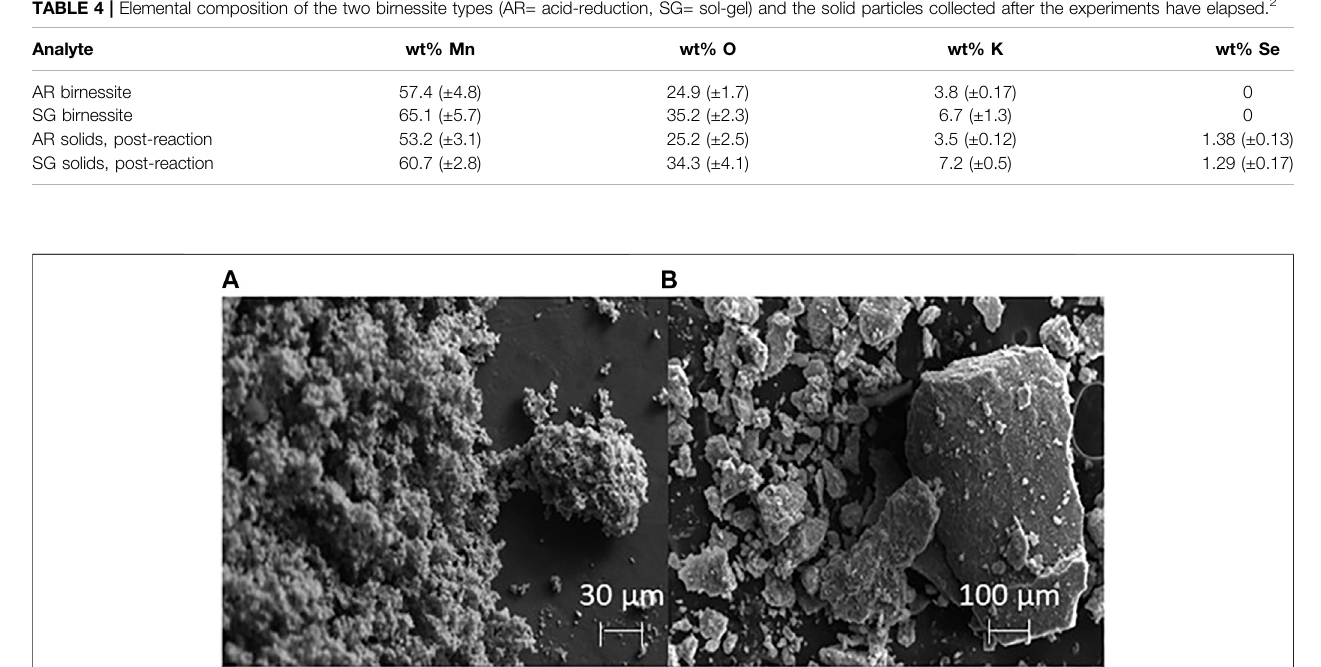
Frontiers in Earth Science |